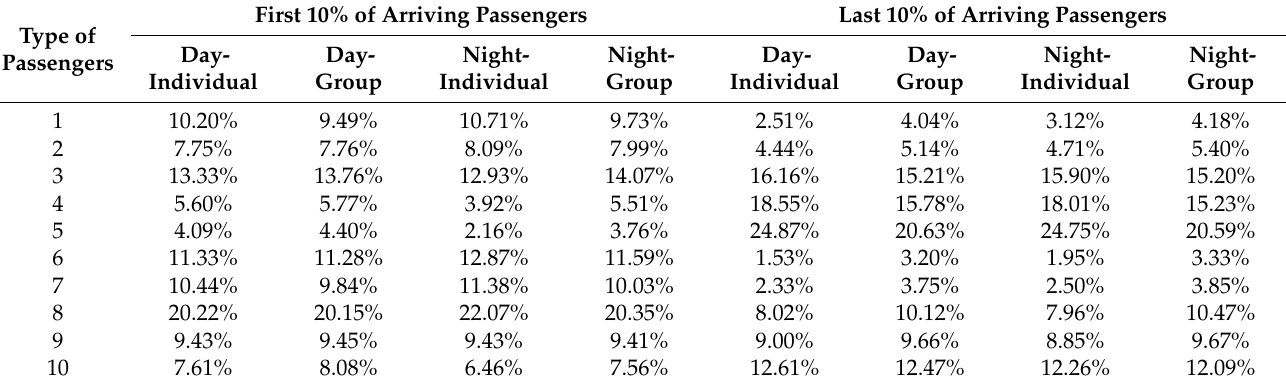
Table 6. Proportions of passengers in different